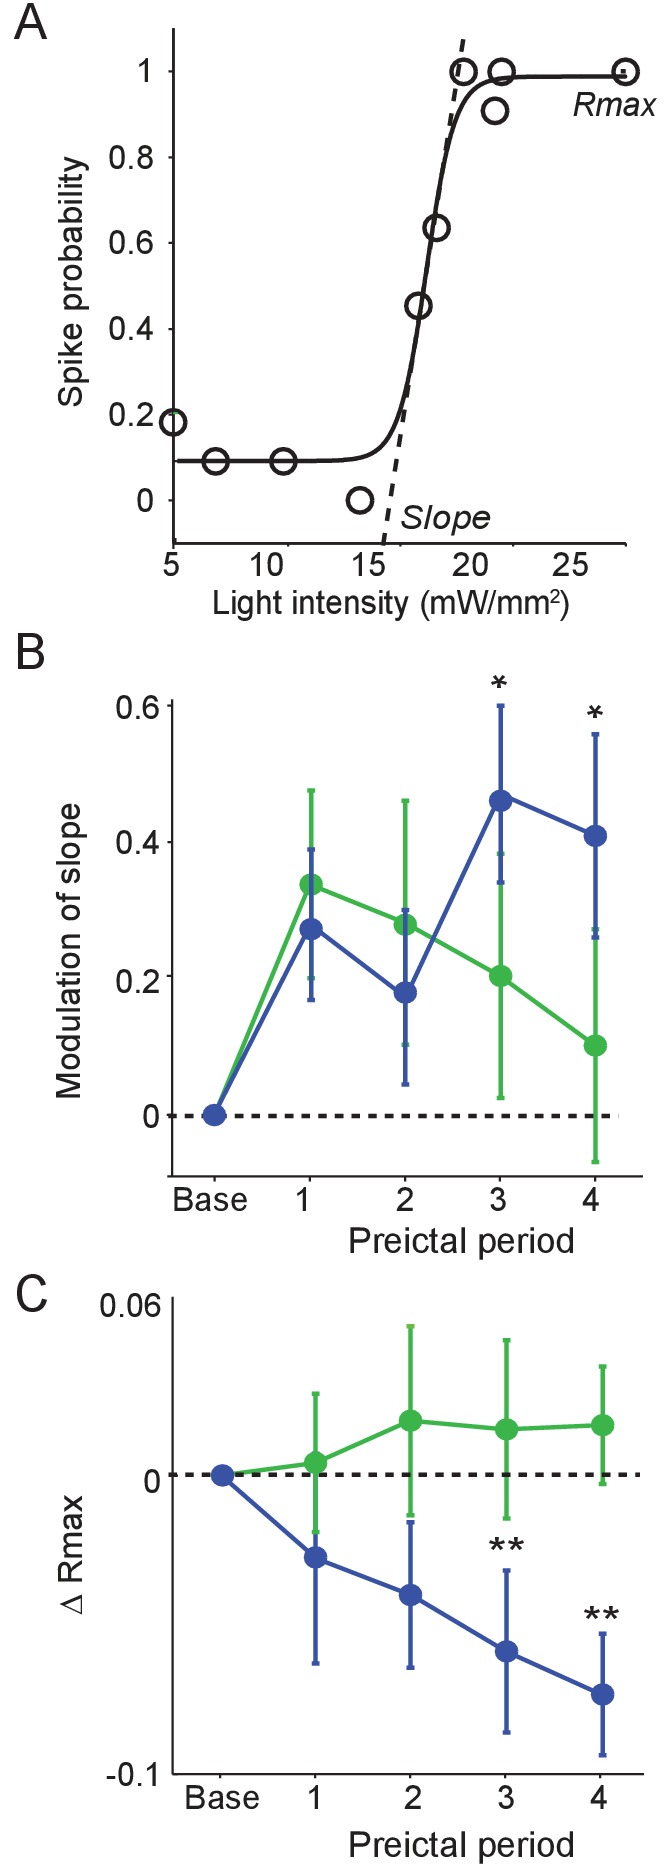
Preictal changes in interneuron sensitivity to inputs (A) Example response curve of spike probability as a function of light pulse intensity (mW/mm2) with sigmoid curve fit, showing slope and maximal response probability (Rmax).(B) Mean modulation of the slope parameter compared to baseline over four preictal periods for PV (n = 17 cells in 15 mice) and SST (n = 21 cells in 20 mice) cells. (C) Mean change in Rmax compared to baseline (dotted line) over four preictal periods for PV and SST cells. (B–C) Significance to baseline: *p<0.0125, **p<0.0025, ***p<0.00025. Error bars denote mean ±s.e.m.10.7554/eLife.40750.017Figure 5—source data 1.Figure 5 - Statistical results.